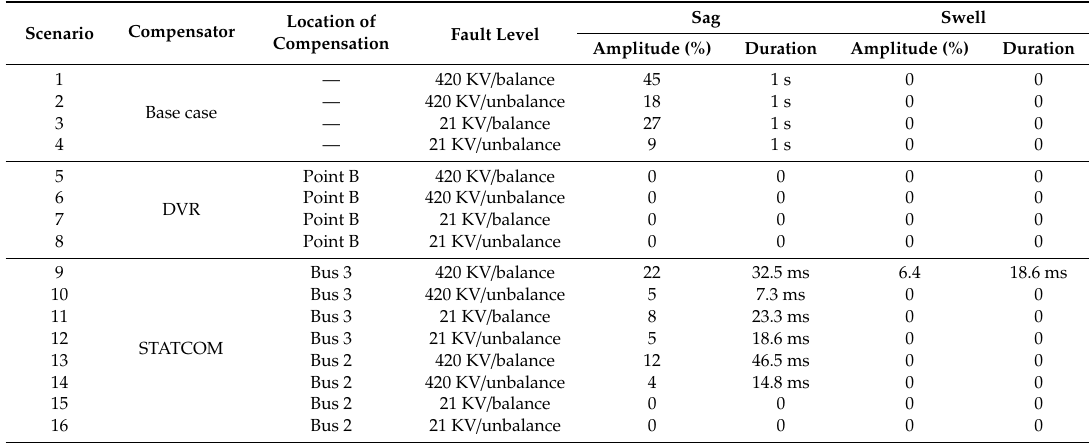
Table 5. Comparison of DVR and STATCOM results.